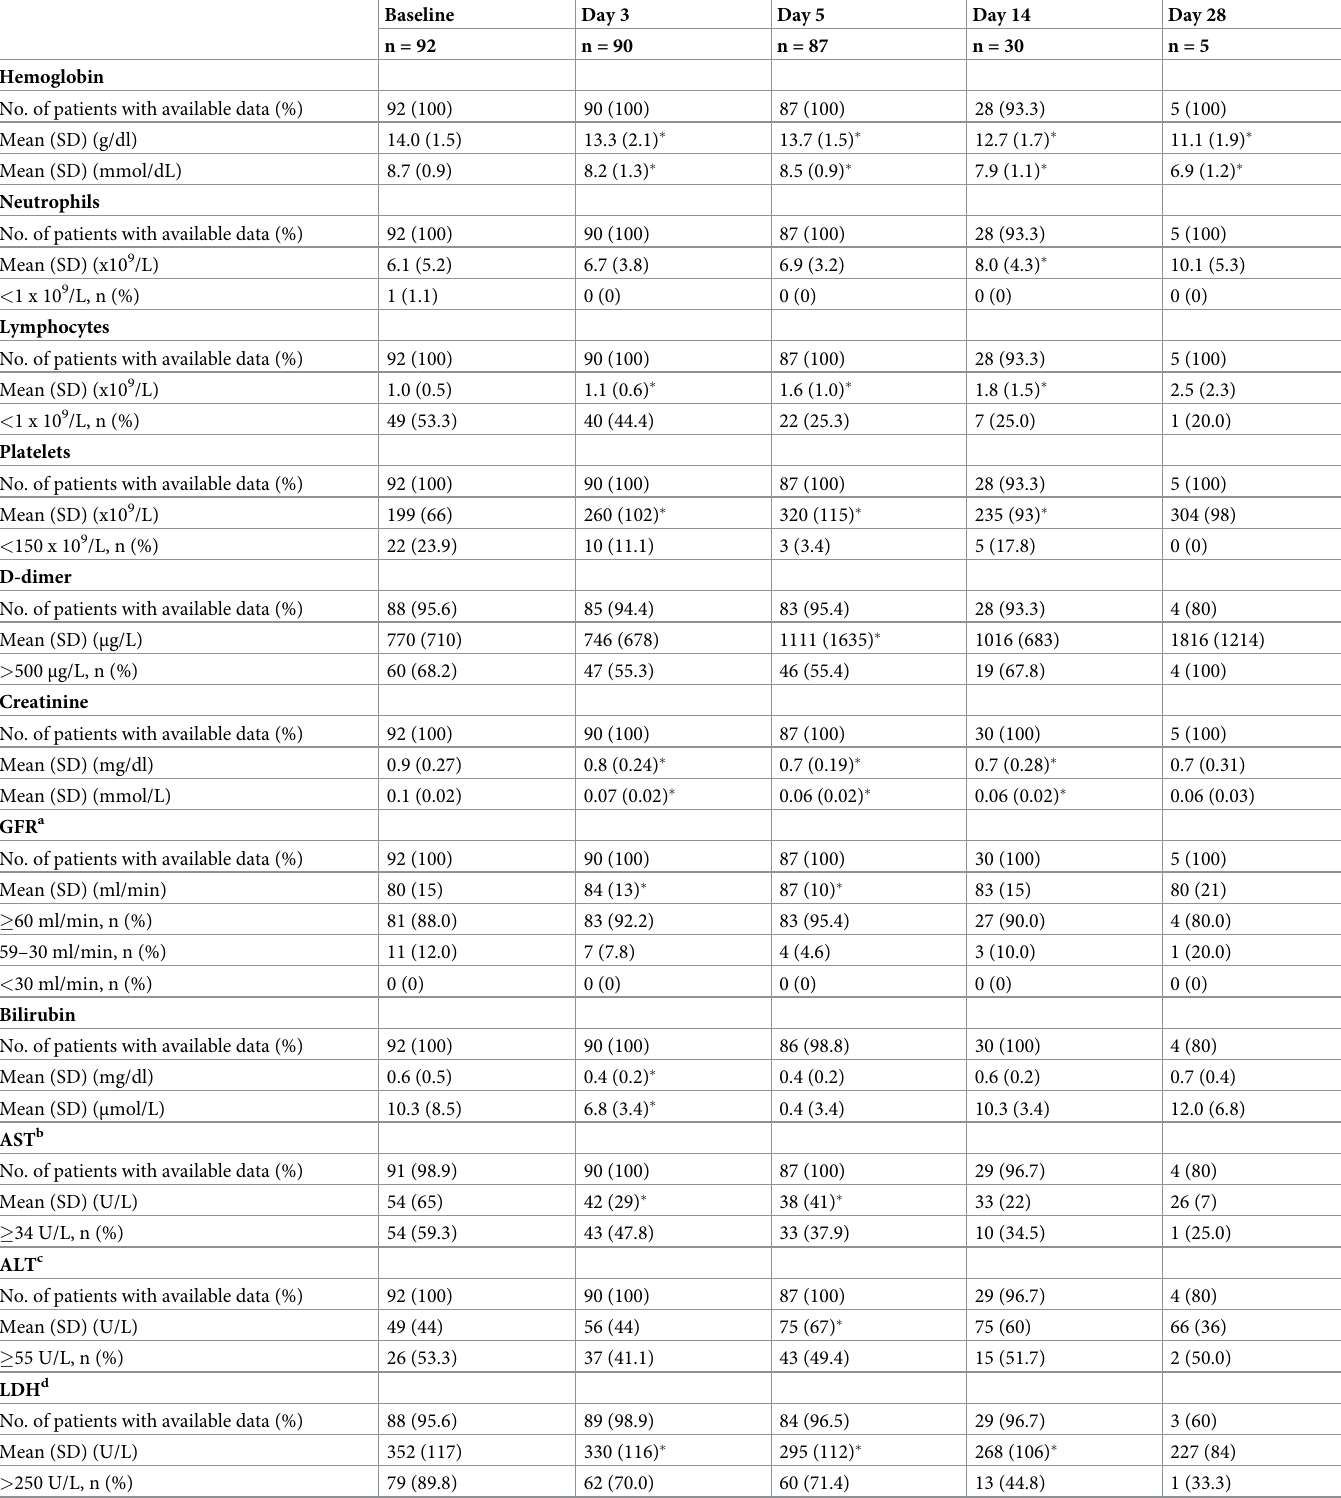
Table 2. Laboratory parameters before, during, and after treatment with